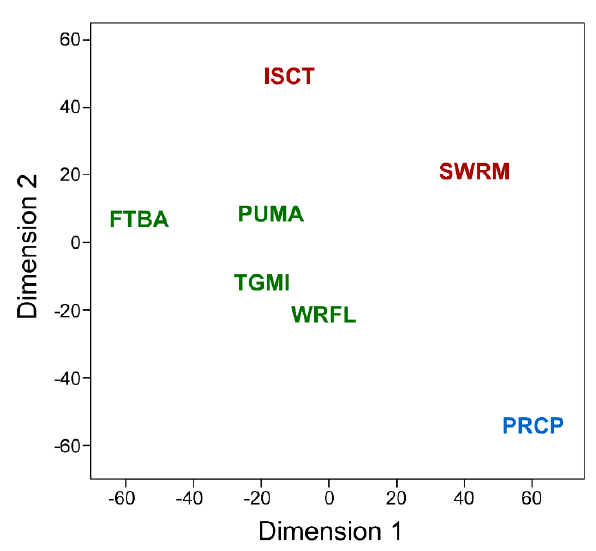
Figure 2. Non-metric multidimensional scaling (MDS) of confusion matrix values from Table 5a. Less distance between classes indicates greater similarity. Vertebrates are colored green, arthropods red, and precipitation blue.